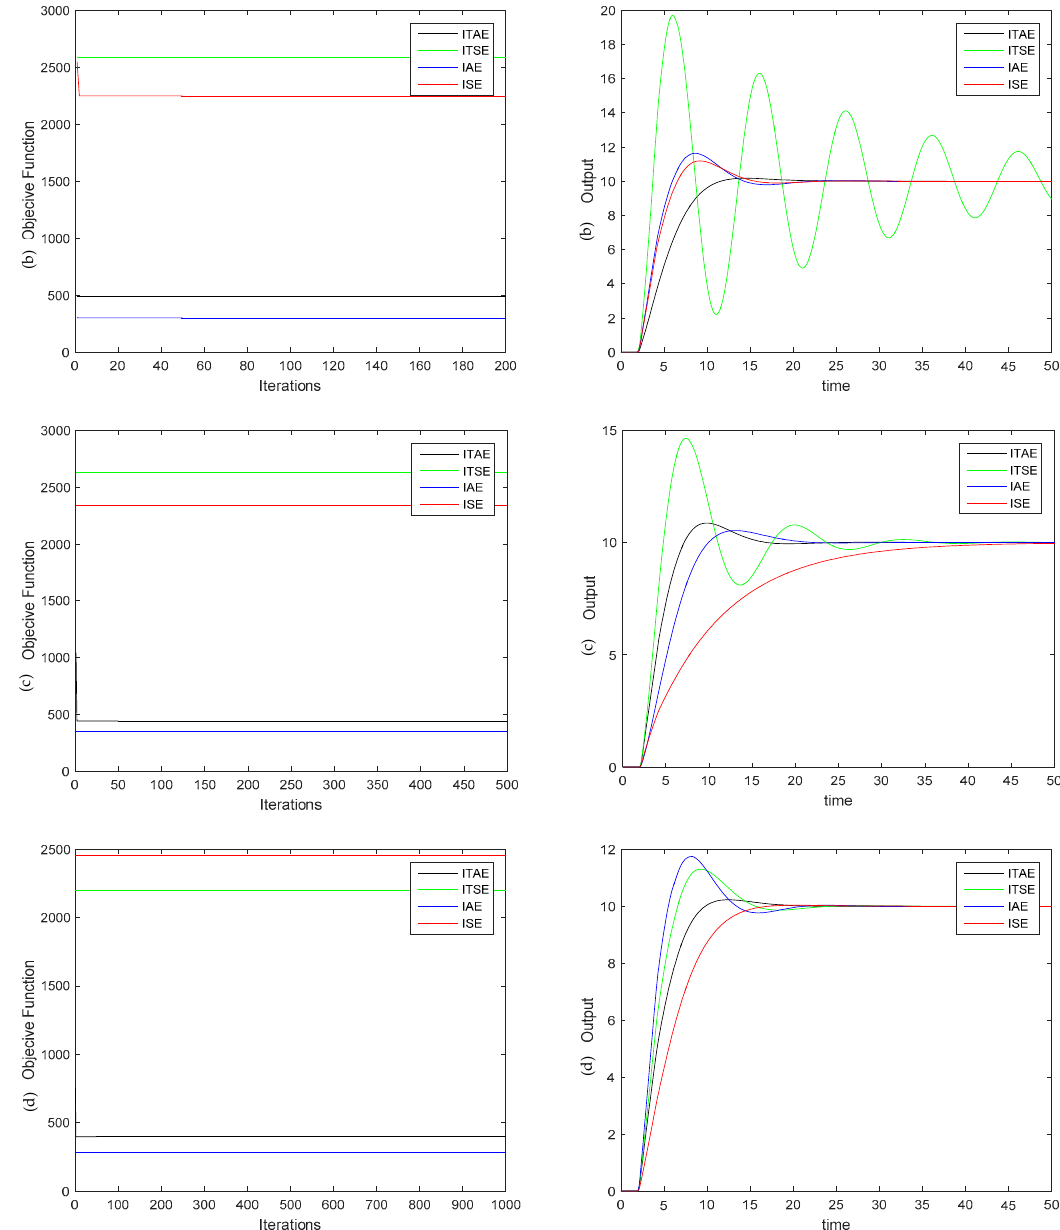
Figure 4. Convergence and time response of the widely used objective function in controller tuning via optimization ( ITAE , ITSE , IAE , ISE ) for different number of iterations ( a ) 100, ( b ) 200, ( c ) 500 and ( d ) 1000 iterations.